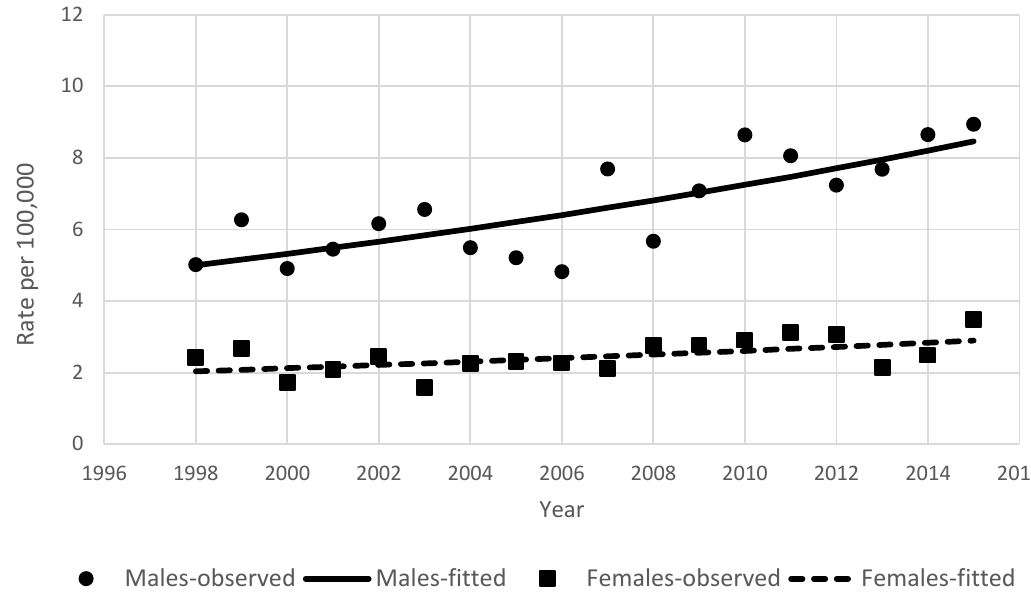
Figure 2. Age-standardized incidence rates of primary liver cancer by sex in Lithuania between 1998 and 2015.